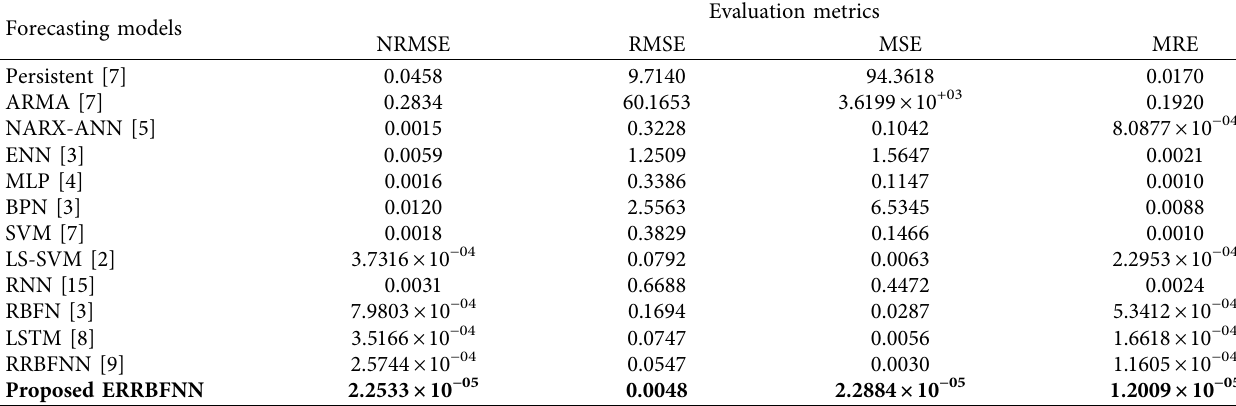
Table 5: Comparative analysis of the proposed ERRBFNN with other forecasting